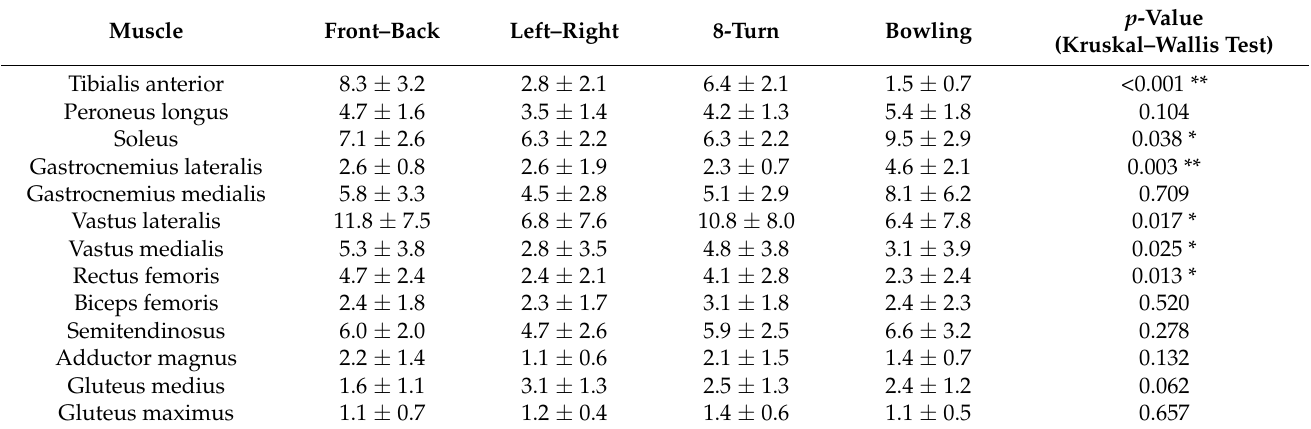
Table 1. Mean %MVIC of leg muscles during LOCOBOT